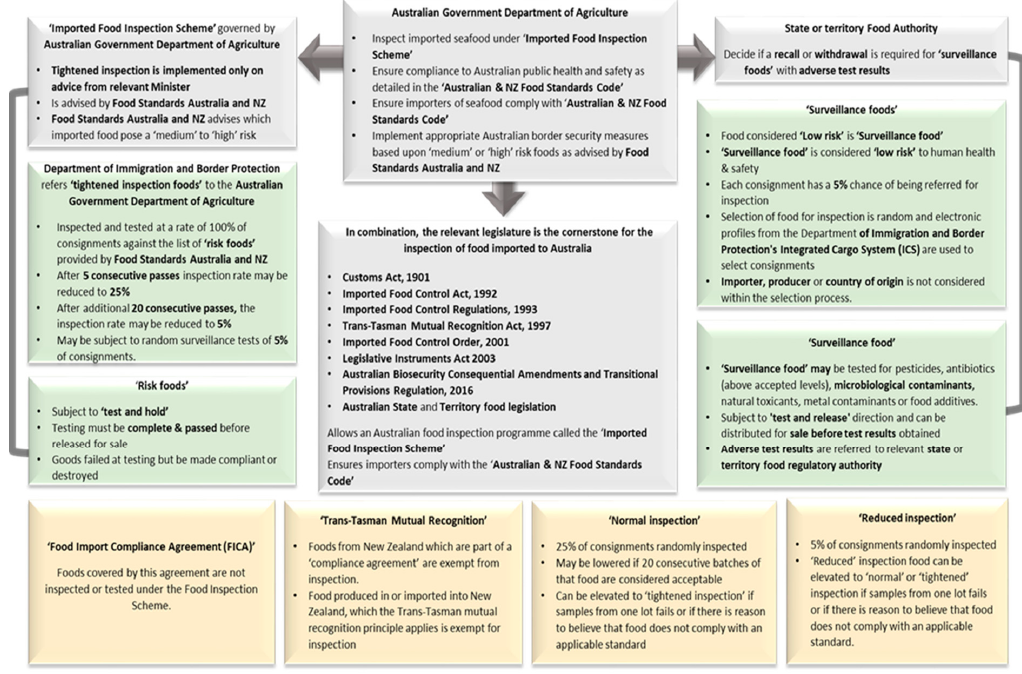
Figure 3. Representation of the legislative instruments that support the inspection of seafood imported to Australia in grey, the testing regimes for ‘surveillance’ and ‘tightened’ inspection for ‘risk foods’ in green. In yellow is the testing regime for ‘normal’, ‘reduced’, ‘compliance’ and foods which have been classified under the ‘Trans-Tasman Mutual Recognition Agreement’. ‘Compliance agreements’ are with the standard of their food management systems which is audited annually. The original figure was developed from information at